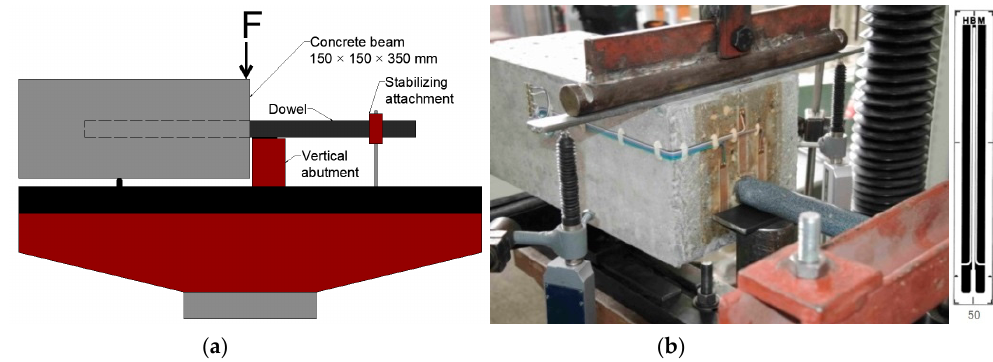
Figure 2. ( a ) Czech loading scheme and ( b ) loading test of beam “A” with 50 mm strain gauges (vertical translation).